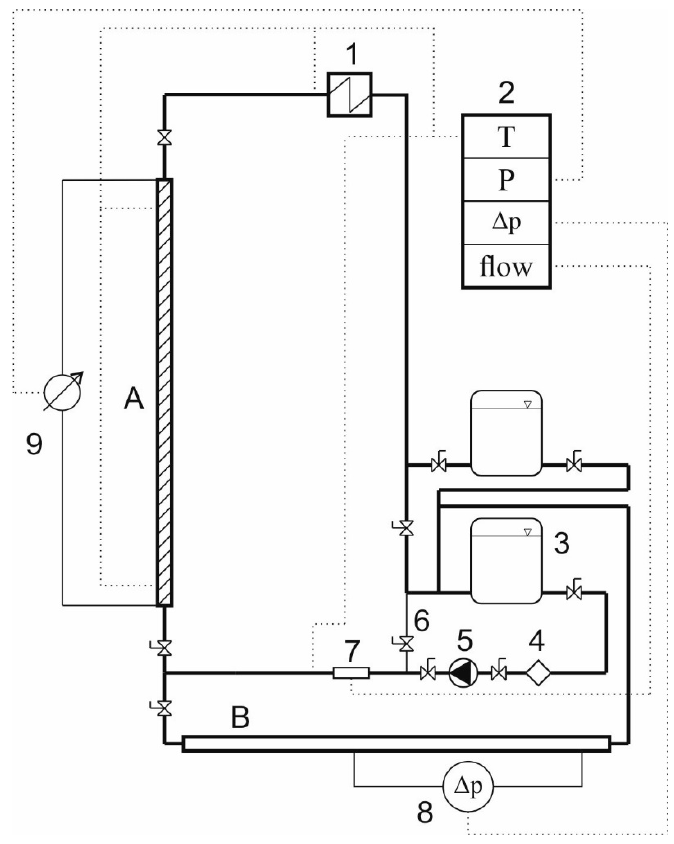
Figure 1. Diagram of the test stand: A—rifled tube to determine the heat transfer coefficient; B— horizontal segment for friction ‐ related pressure loss testing; 1—cooler; 2—data acquisition system;